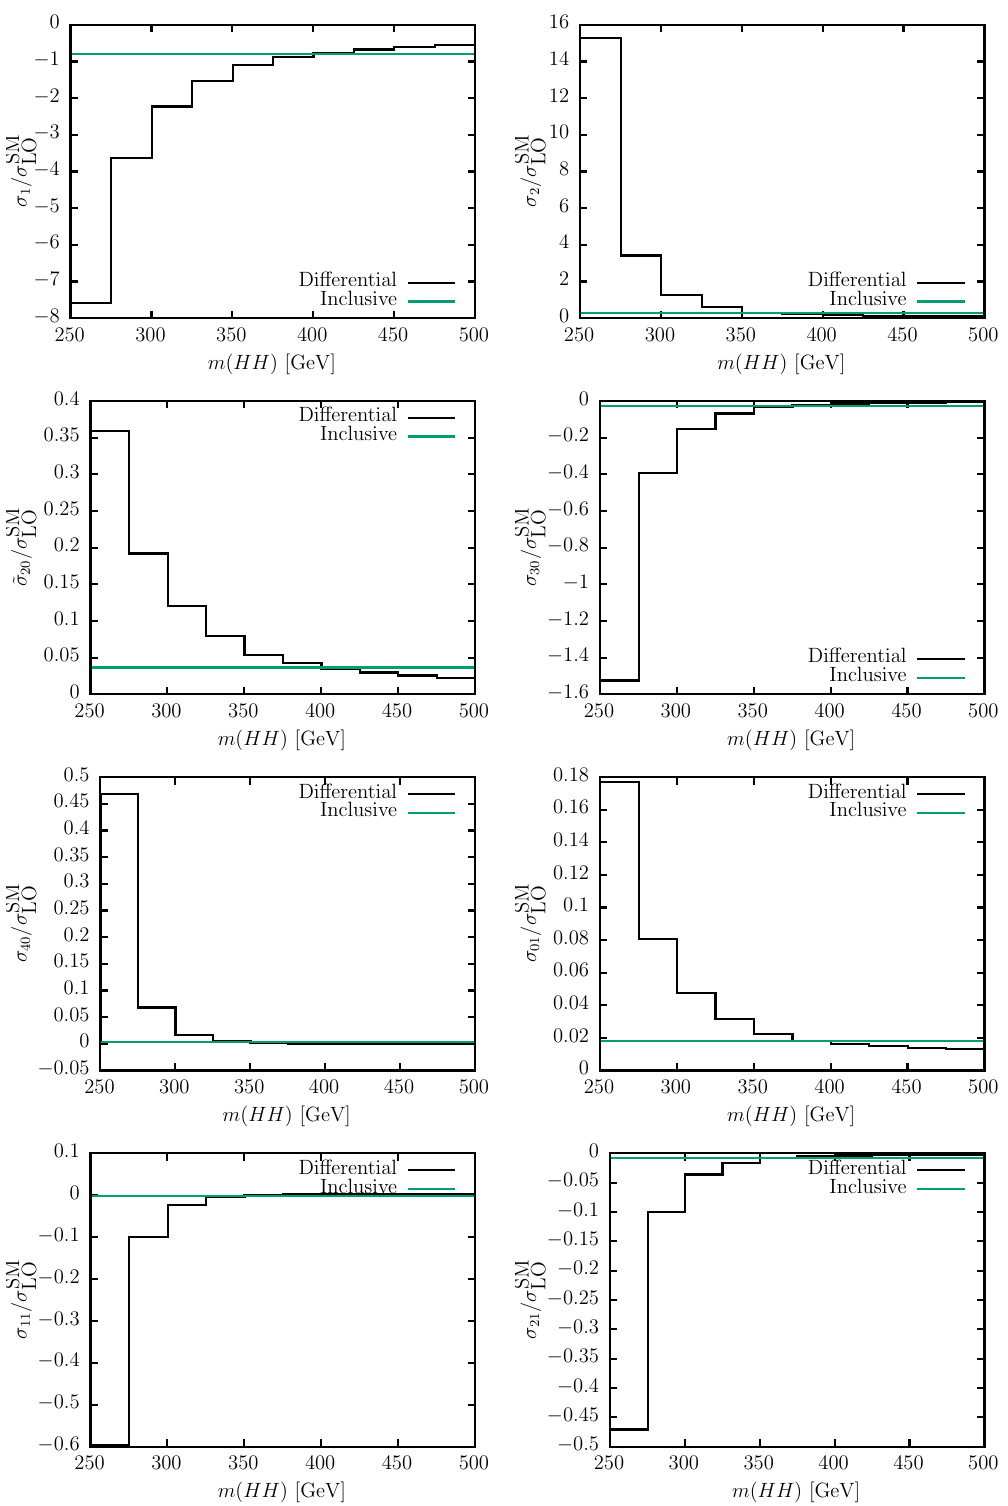
Figure 8 . Relative impact of the (cid:27) contributions to the m ( HH ) distribution at 14 TeV (black) i ( j ) compared to the same quantity at total cross section level